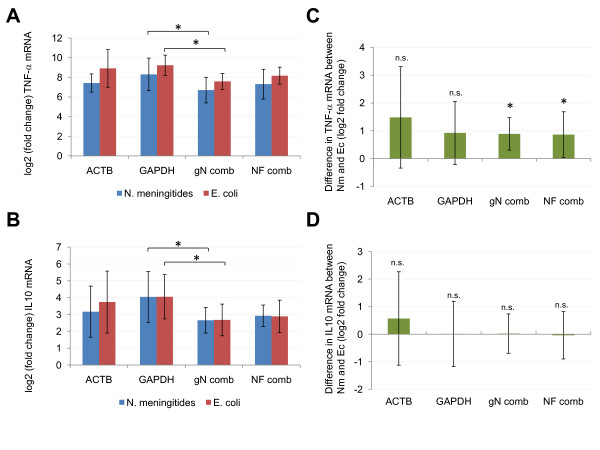
Comparison of different normalization strategies. Shown are mRNA expression results from different normalization strategies of TNF-α (panel A, C) and IL10 (panel B, D) in monocytes stimulated for 3 h with LPS compared to non-stimulated cells. The following normalization approaches were applied: The combinations of best-performing reference genes as calculated by geNorm (PPIB, B2M and PPIA; gN comb) or Normfinder (TBP and B2M; NF comb), the best-performing gene as indicated by Normfinder (ACTB) and another frequently used reference gene, GAPDH. (A) and (B) illustrate expression level changes as log2 of the fold change in mRNA levels between stimulated (LPS from N. meningitides, blue bars, and LPS from E. coli, red bars) and non-stimulated cells (not shown). (C) and (D) show the difference in TNF-α and IL10 mRNA, respectively, between monocytes stimulated with equimolar concentrations of LPS from N. meningitides (Nm) and E. coli (Ec) for 3 h based on different normalization approaches. Statistical significance was assessed by Wilcoxon matched pairs signed ranks test, and selected differences are indicated. Results with p < 0.05 are regarded as statistically significant and indicated by asterisks. Paired student's t test was also performed and resulted in similar findings (data not shown). n.s. not significant. Error bars indicate ± SD.